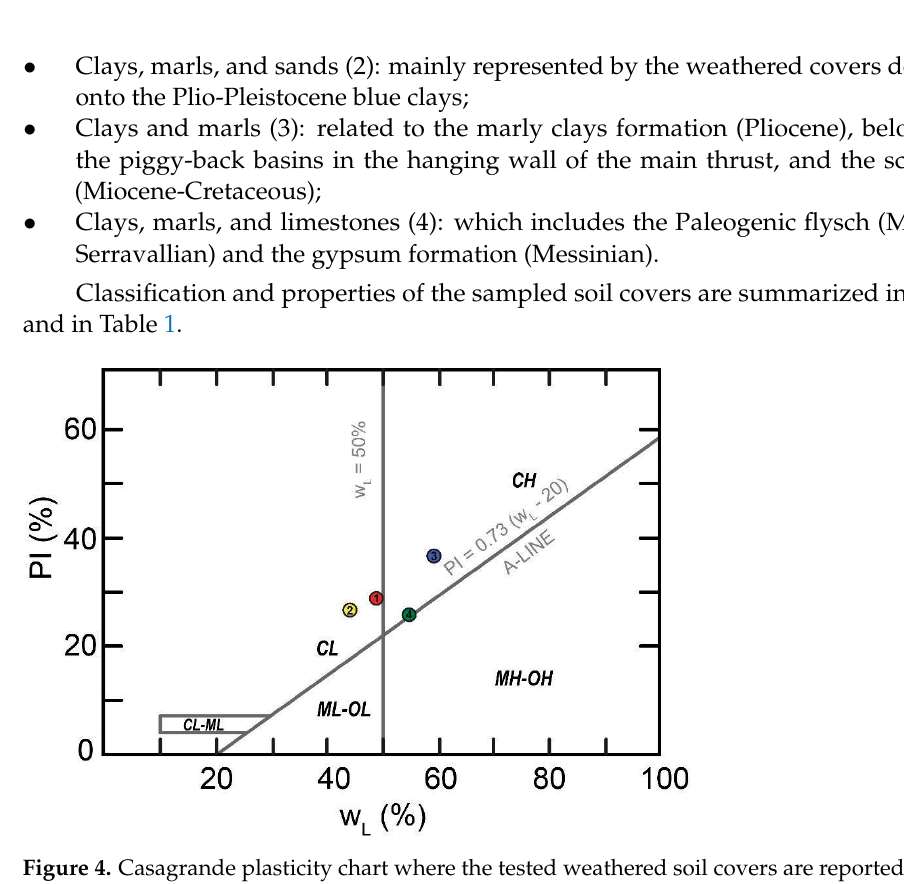
Figure 4. Casagrande plasticity chart where the tested weathered soil covers are reported. Table 1. Table reporting lithotechnical parameters obtained by laboratory tests and in accordance with pre-existing DBs (friction angles and cohesion). USCS classification of the four geotechnical units adopted for the soil covers are reported.